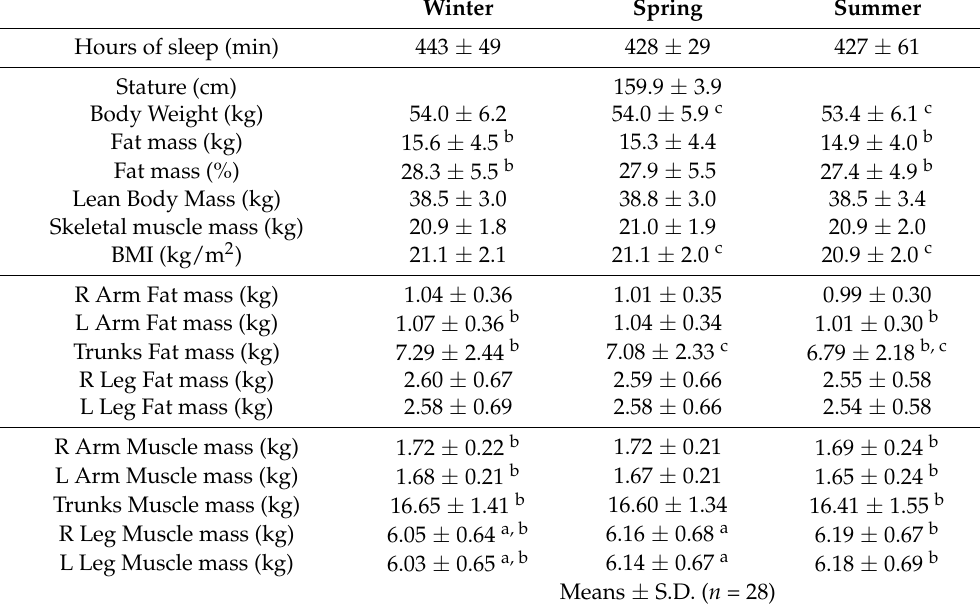
Table 2. Seasonal changes in body composition.